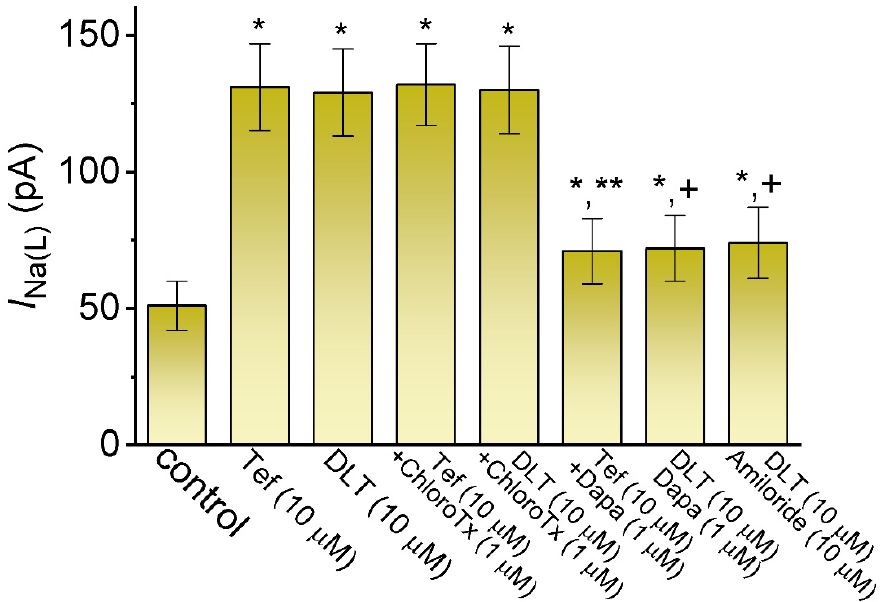
Figure 2. Comparison among effects of Tef, DLT, Tef plus chlorotoxin (ChloroTx), DLT plus ChloroTx, Tef plus dapagliflozin (Dapa), DLT plus Dapa, and DLT plus amiloride on the amplitude of I Na(L) measured from GH 3 cells. The I Na was elicited by 20 ms depolarizing voltage command from − 80 to − 10 mV for a duration of 20 ms at a rate of 0.2 Hz. The I Na(L) amplitudes during exposure to different tested compounds were measured at the end of each depolarizing step. Each bar represents the mean ± SEM ( n = 8). * Significantly different from control ( p < 0.05), ** significantly different from Tef (10 μ M) alone group ( p < 0.05), and + significant different from DLT (10 μ M) alone group ( p < 0.05).